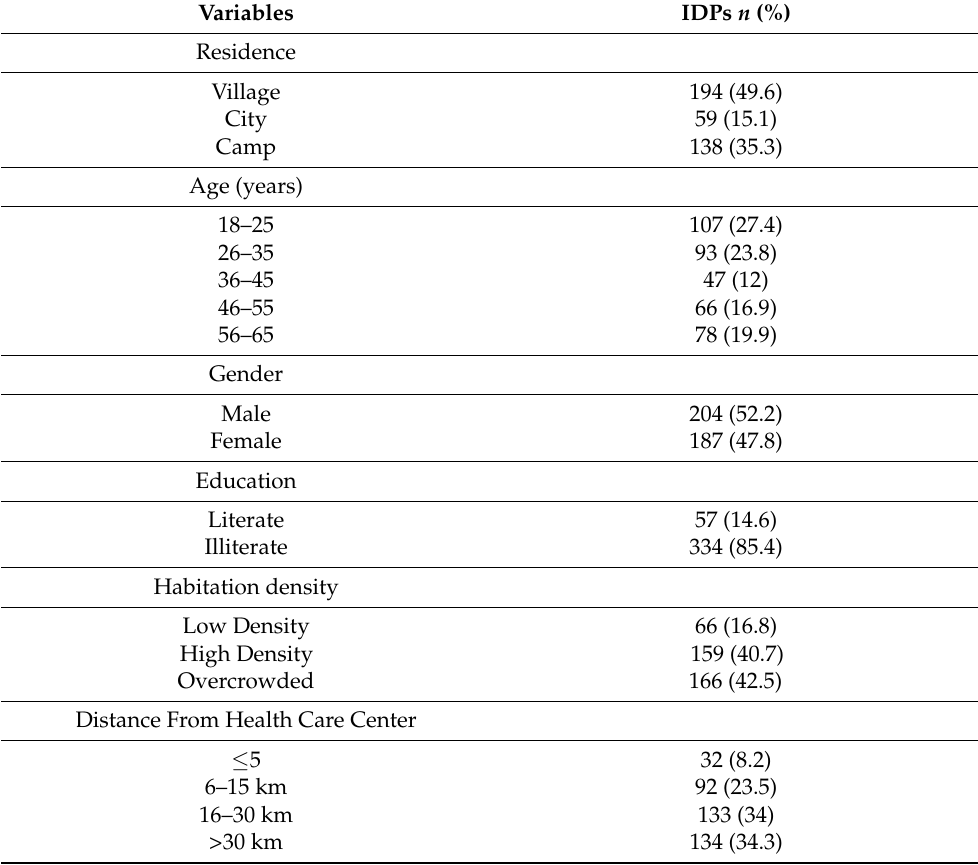
Table 1. Sociodemographic characteristics of the TB patients enrolled in the